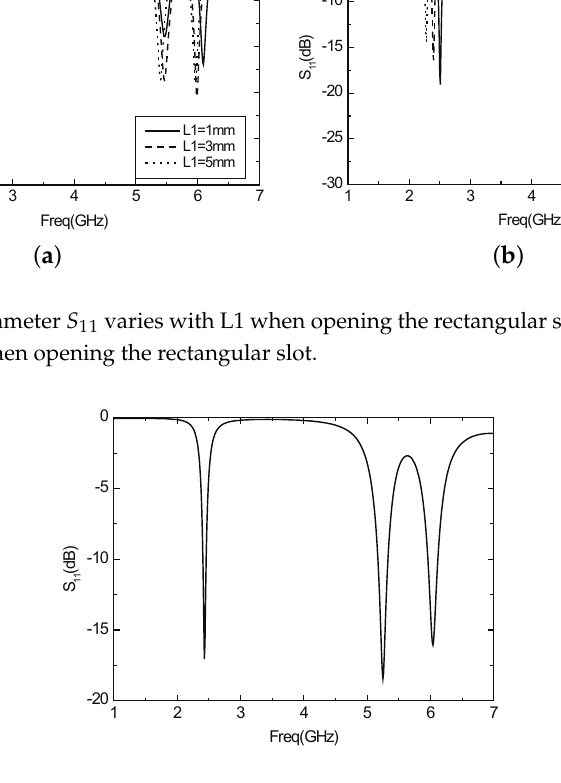
Figure 18. S 11 parameter curve of the optimized